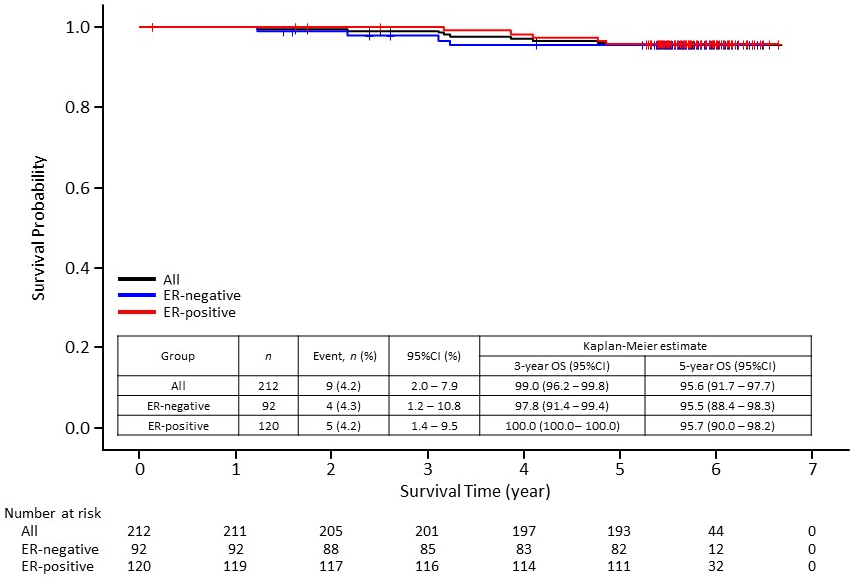
Figure 3. Kaplan–Meier curves of overall survival (OS) in 212 patients enrolled in the Neo-LaTH study comprising 92 estrogen receptor (ER)-negative and 120 ER-positive patients. CI, confidence interval.